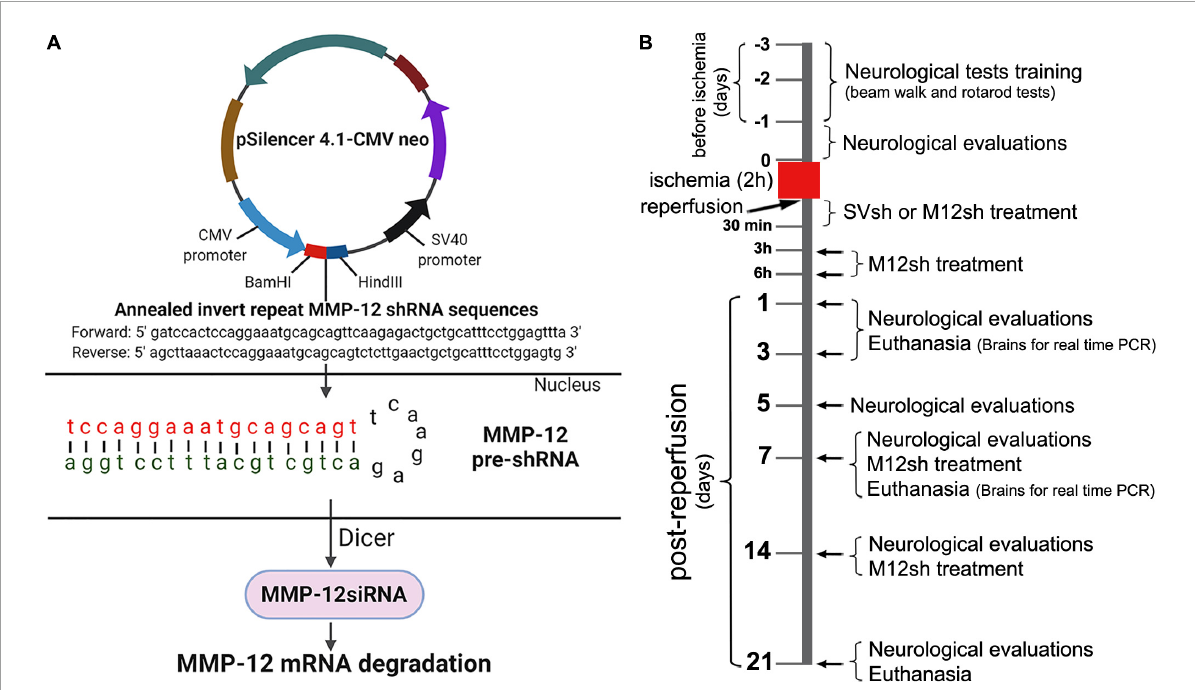
FIGURE1 Schematic representation of the MMP-12 shRNA plasmid construct and mechanism of target gene silencing, experimental design, and timing of the main experimental procedures. (A) The construct consists of the annealed invert repeat MMP-12 shRNA sequences ligated between Bam HI and Hin dIII sites of the pSilencer 4.1-CMV neo expression vector. Following the entry of plasmids into the nucleus of a cell, the CMV promoter drives the formation of the MMP-12 pre-shRNA, a short hairpin molecule specific to MMP-12. The Dicer processes MMP-12 pre-shRNA molecules and the resulting MMP-12 siRNA molecules interact with the target MMP-12 mRNA. This interaction leads to the degradation of MMP-12 mRNA and suppression of MMP-12 gene expression. (B) Rats from both sexes were subjected to transient focal cerebral ischemia for 2 h, followed by reperfusion and various treatments. Rats from the appropriate cohorts were euthanized on various post-reperfusion days, and their brains were processed for real-time PCR analysis. Additional animals from the appropriate cohorts were assessed in various neurological and functional tests at baseline and at regular intervals (post-reperfusion days 1, 3, 5, 7, 14, and 21) after a 2-h focal cerebral